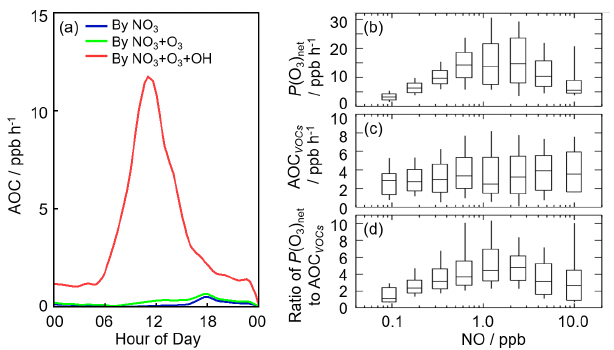
Figure 8. (a) The diurnal profiles of AOC in this campaign. (b) NO dependence on P (O 3 ) net during the daytime. (c) NO dependence on AOC VOCs during the daytime, and AOC VOCs denotes the atmo- spheric oxidation capacity only from the VOC oxidation. (d) NO dependence on the ratio of P (O 3 ) net to AOC VOCs during the day- time. The box–whisker plots in panels (b) – (d) give the median, the 75th and 25th percentiles, and the 90th and 10th percentiles of P (O 3 ) net , AOC VOCs , and the ratio of P (O 3 ) net to AOC VOCs , re-